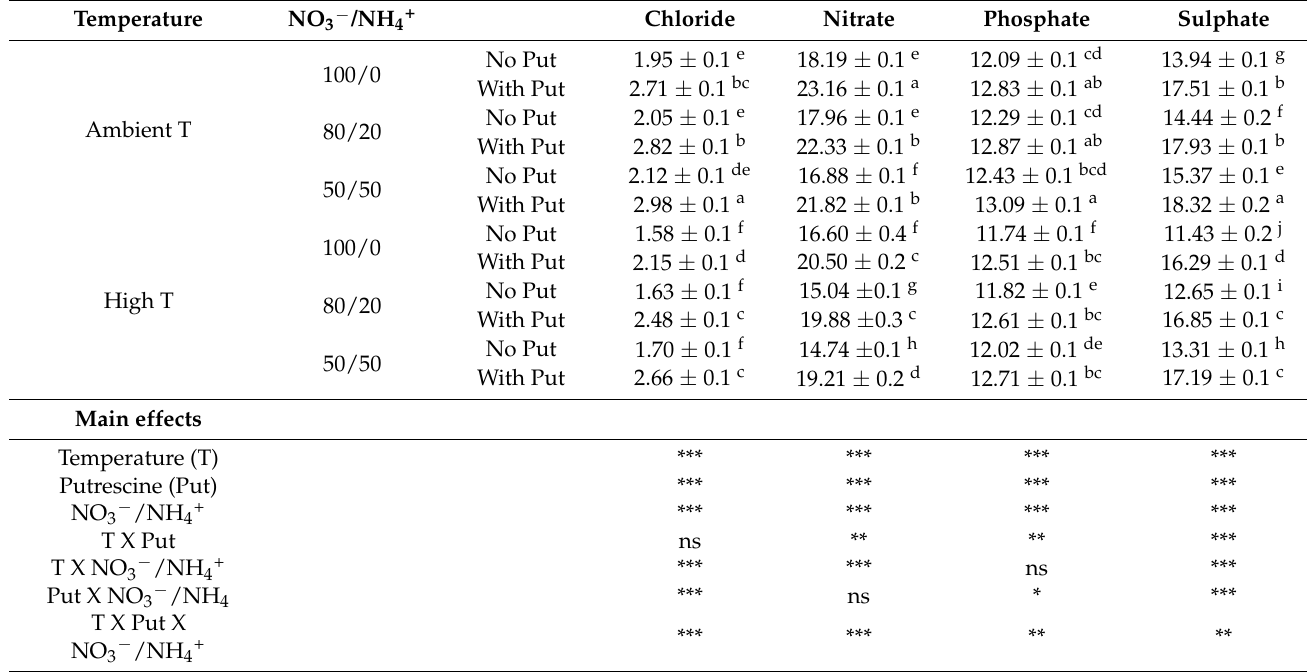
Table 8. Effect of foliar application of putrescine on anions (g kg − 1 FW) in older leaves of the cauliflower cv. Moonshine at different ration of NO 3 − /NH 4+ and